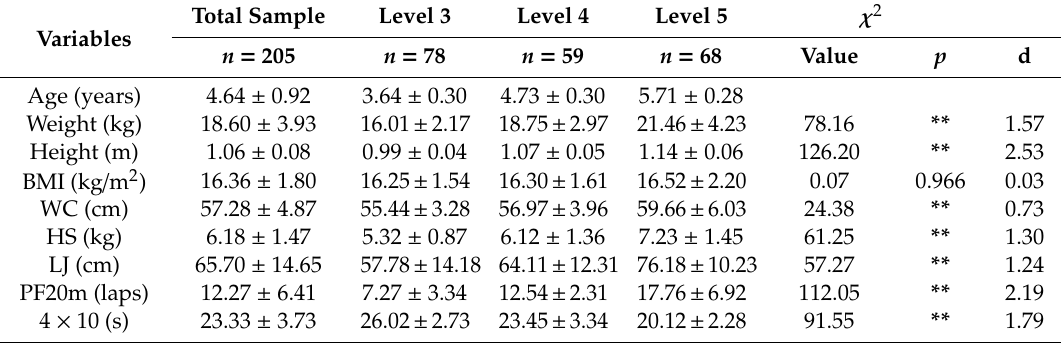
Table 1. Descriptive characteristics of participants and mean di ff erences of PREFIT physical fitness tests divided by level